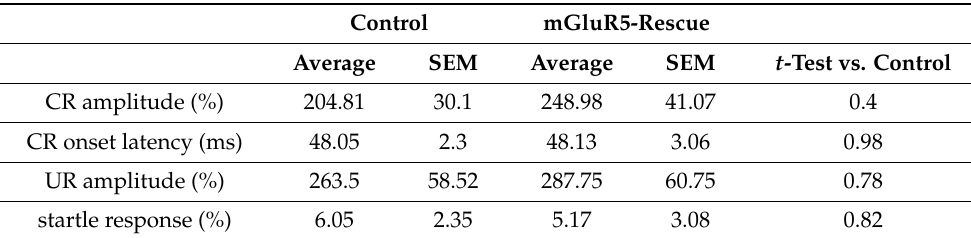
The Comparison of eyeblink conditioning parameters. The CR amplitude, CR onset latency, UR amplitude, and startle response were calculated on day 7 in the control and mGluR5-rescue mice. Values are group mean ±